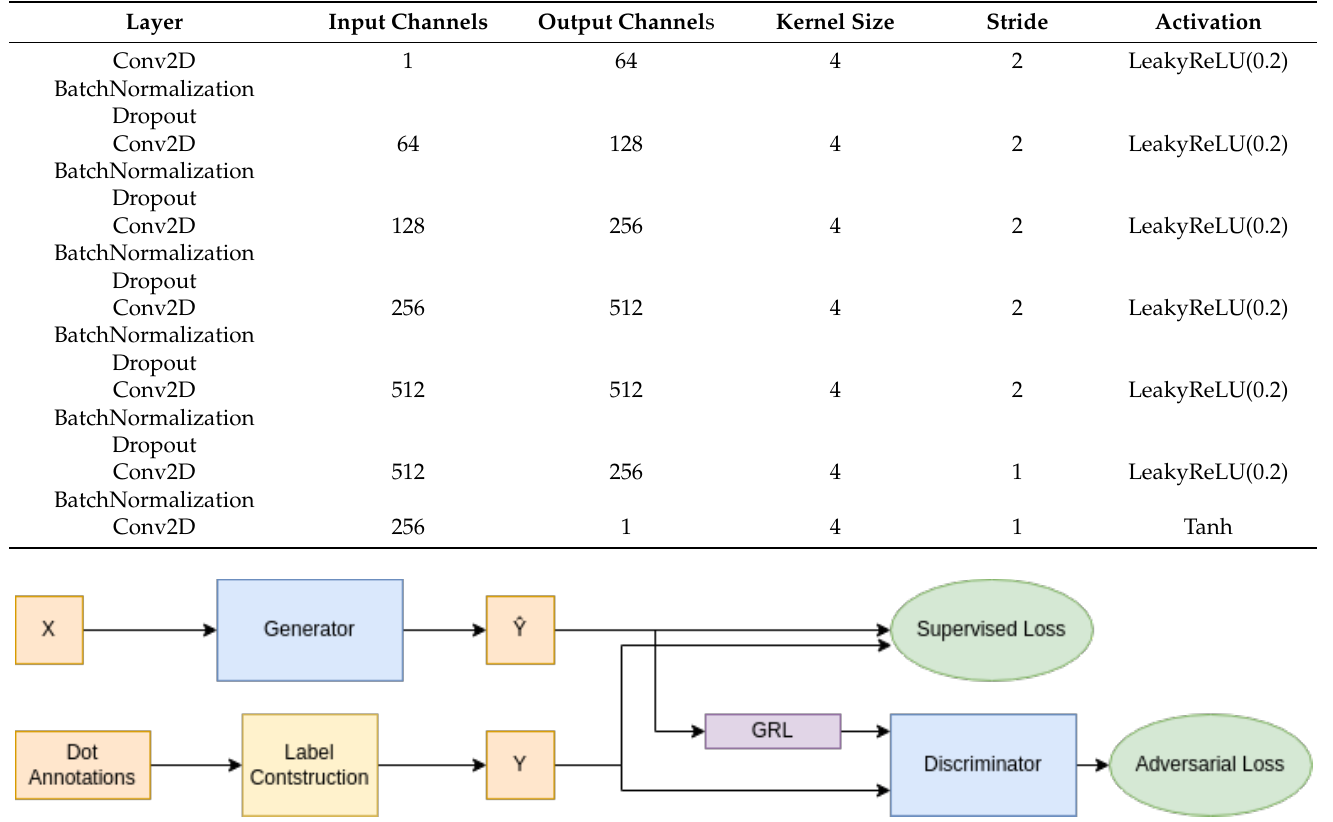
Table 1. The architecture of the discriminator used in our model is presented in this table. We employ LeakyReLU activation functions in all layers except for the output layer, which uses the hyperbolic tangent function. With a stride of 32 pixels, this discriminator can effectively analyze and distinguish structures of up to that size.